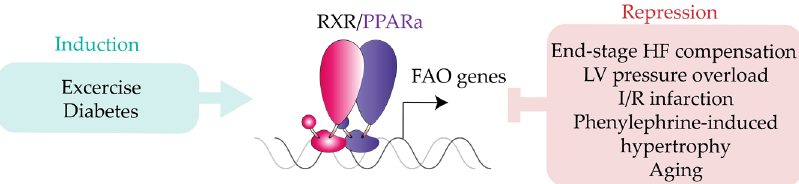
Figure 3. Cardiac stimuli-induced PPAR regulation. Schematic representation of those inductive and repressive signals that modulate cardiac PPAR expression. RXR, retinoid X receptor. PPARa, peroxisome proliferator-activated receptor alpha. FAO, fatty acid oxidation. HF, heart failure. I/R, ischemia/reperfusion. LV, left ventricle.